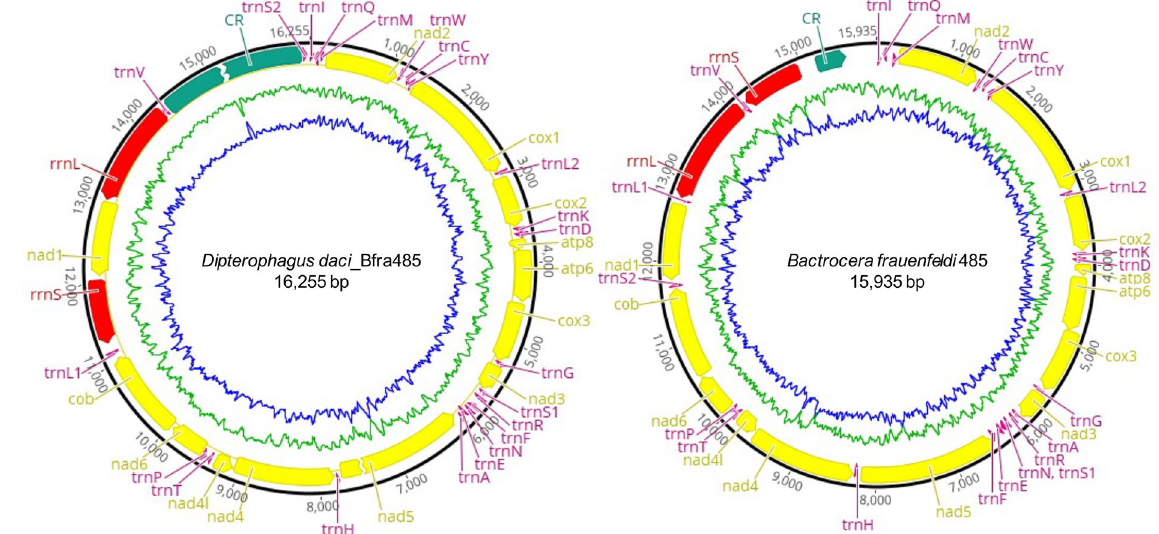
Figure 1. Structure of the mitogenomes of Dipterophagus daci and Bactrocera frauenfeldi obtained from a whole genome sequencing library of the genomic extract of the parasitised specimen B. frauenfeldi Bfra485. PCGs are denoted in yellow, rRNA genes in red, tRNA genes in purple and control region in green. The AT content (blue) and GC content (green) were plotted as the deviation from the average AT and GC content of the overall sequence using sliding window analysis. The mitogenome of D. daci has not been closed and contains one unusual single nucleotide frameshift deletion in the nad5